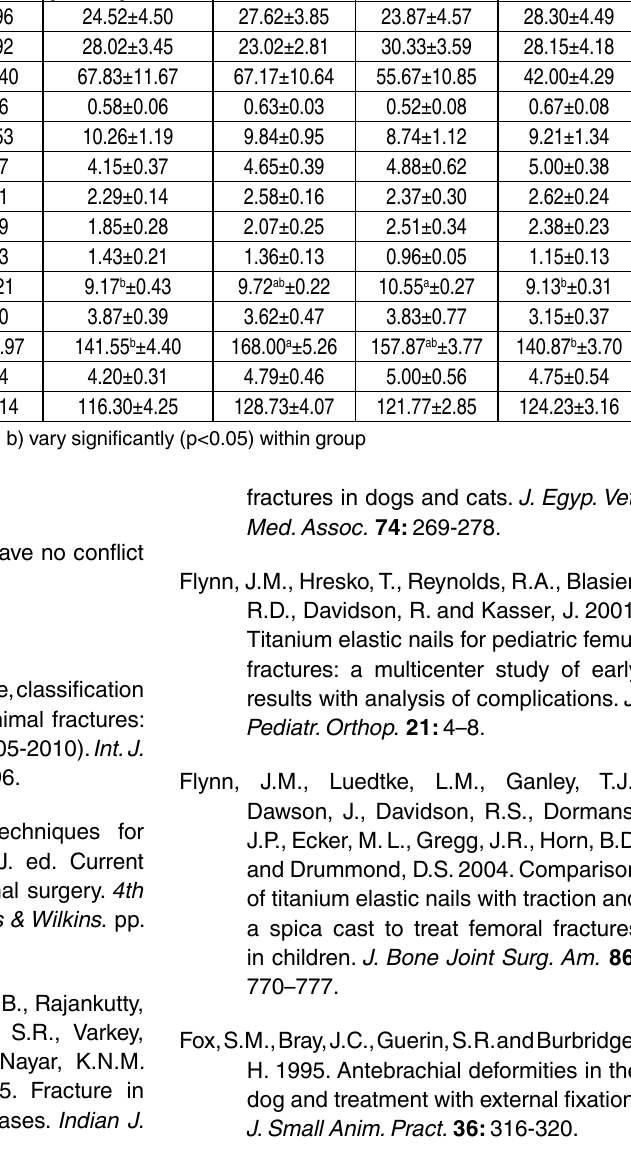
table 8. Mean ± S.E. values of different serum biochemical parameters of all the cases at different time intervals of examination time